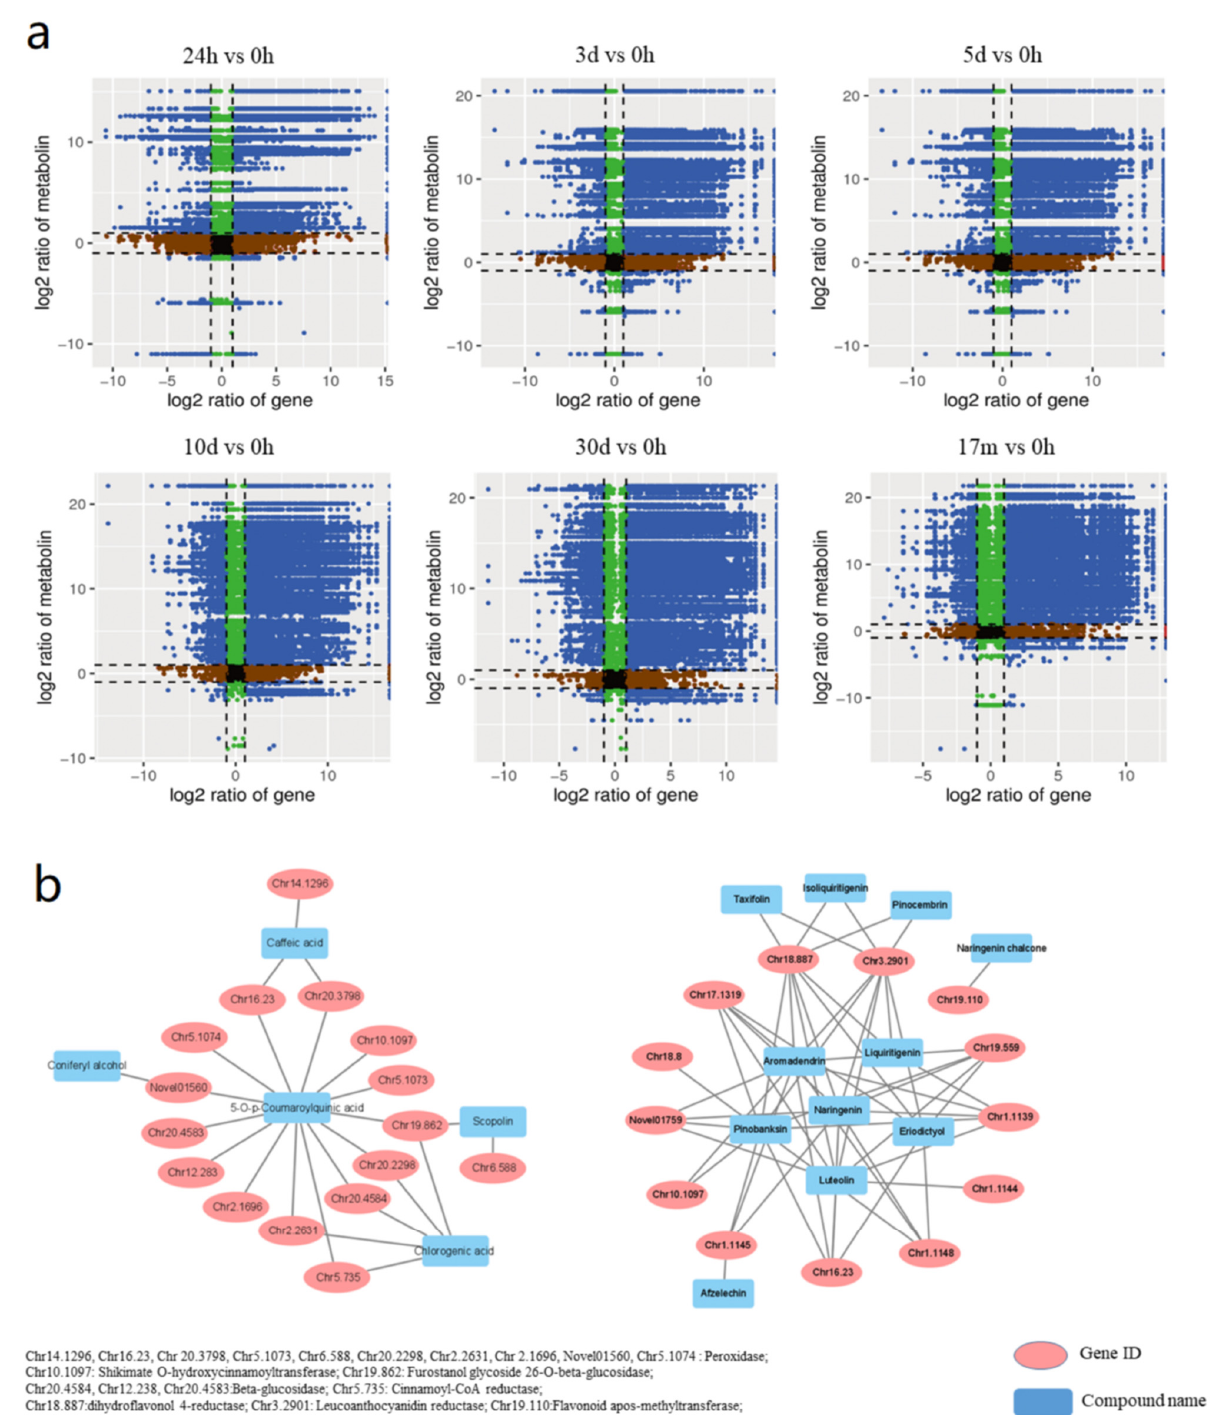
Figure 4. Correlation analysis of DEGs and DEMs: ( a ) nine-quadrant diagram of unigenes and compounds at different wounding timepoints. Unigenes and compounds in quadrants 3 and 7 have accordant tendency; unigenes and compounds in quadrants 1 and 9 have reverse tendency; unigenes and compounds in quadrant 5 are not differentially expressed; unigenes and compounds in quadrants 2, 4, 6, and 8 have no obvious tendency; ( b ) network of DEGs and DEMs in phenylpropanoid biosynthesis and flavonoid biosynthesis pathways.